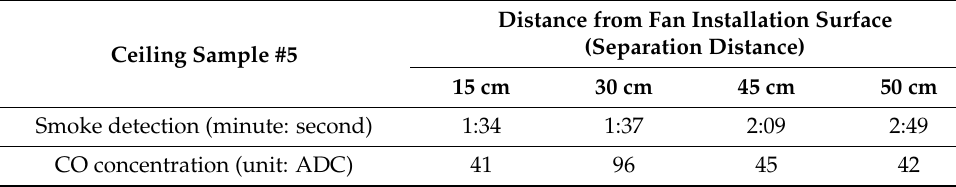
Figure 18. Time comparison test result by ignition source height. Table 4. Performance in terms of detection time for smoke time and carbon monoxide from ignition source height of 0 cm